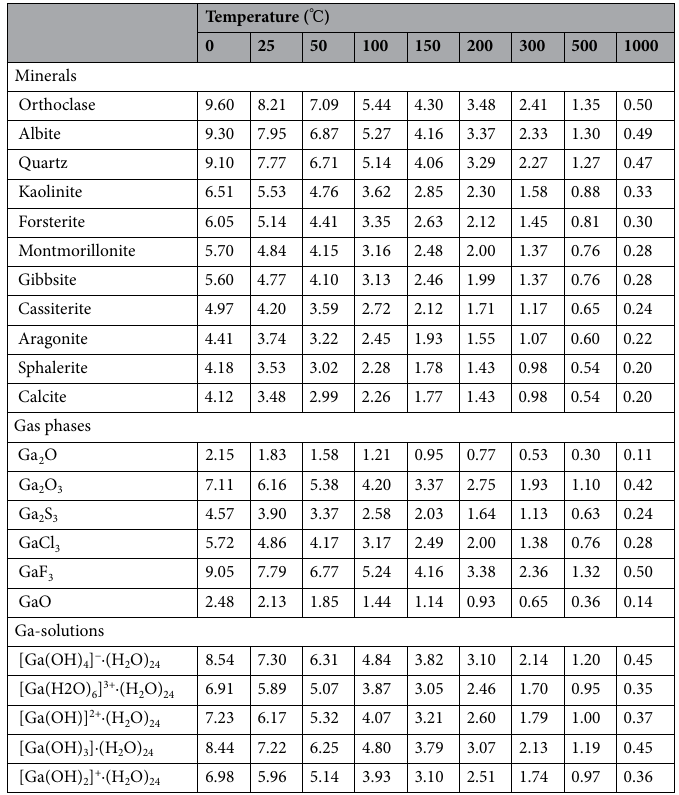
Table 1. 10 3 ln(RPFR) values of different Ga-bearing species at different